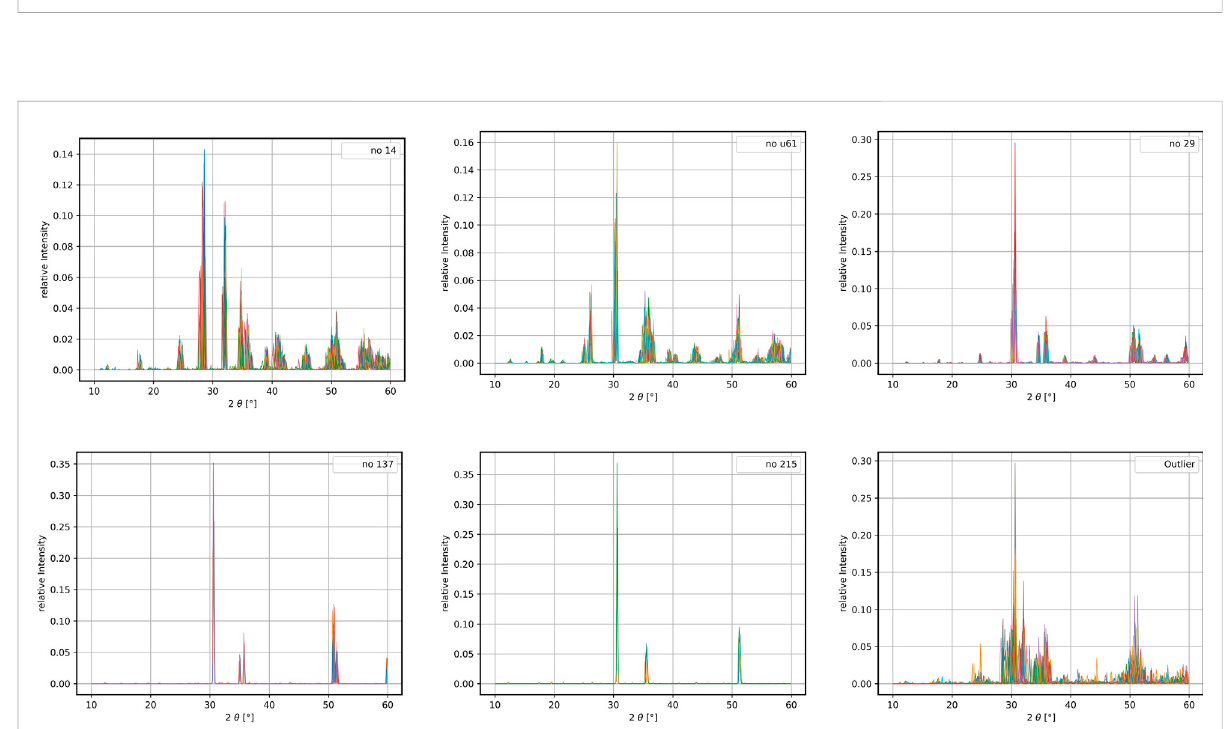
FIGURE 6 The Sankey diagrams for HfO 2 and ZrO 2 display on the left border the initial phases, which are subjected to doping and on the right border the detected clusters. This visualizes the phase-evolutions under doping for different crystal phases. In both material systems the m-phase (no 14) and the oI*-phase (no u61) are the most stable phases, according to their energies, whereas the oIII-phase (no 29) and the t-phase (no 137) are more prone to phase transitions.